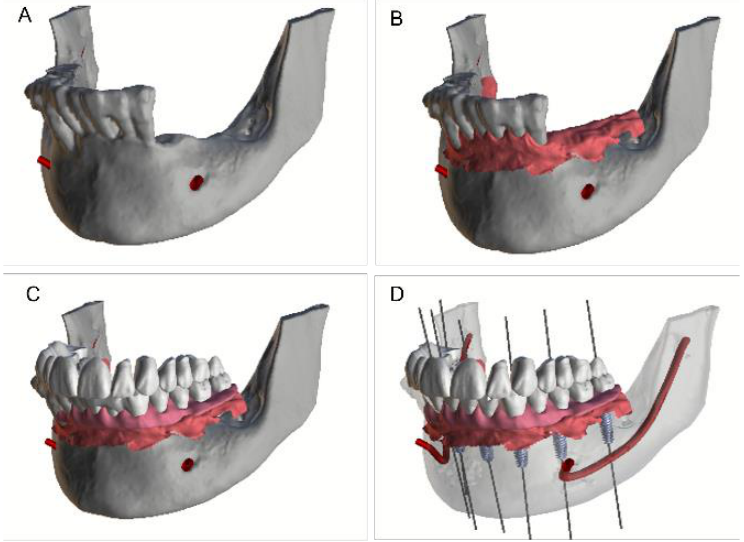
Figure 3. Virtual planning of the first case (phase 1). Bone defect after segmentation from pre- operative CBCT data ( A ); matching with the pre-operative soft tissue profile from the intra-oral scanning ( B ); superimposition of the digital wax-up and set up of the final ideal gingival architecture ( C ); virtual positioning of the fixtures ( D ).